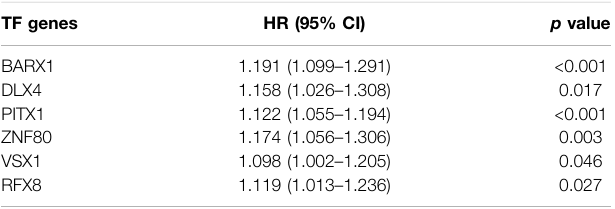
TABLE 1 | Multivariate Cox regression analysis for the six transcription factors ’ expression levels in the TCGA KIRC